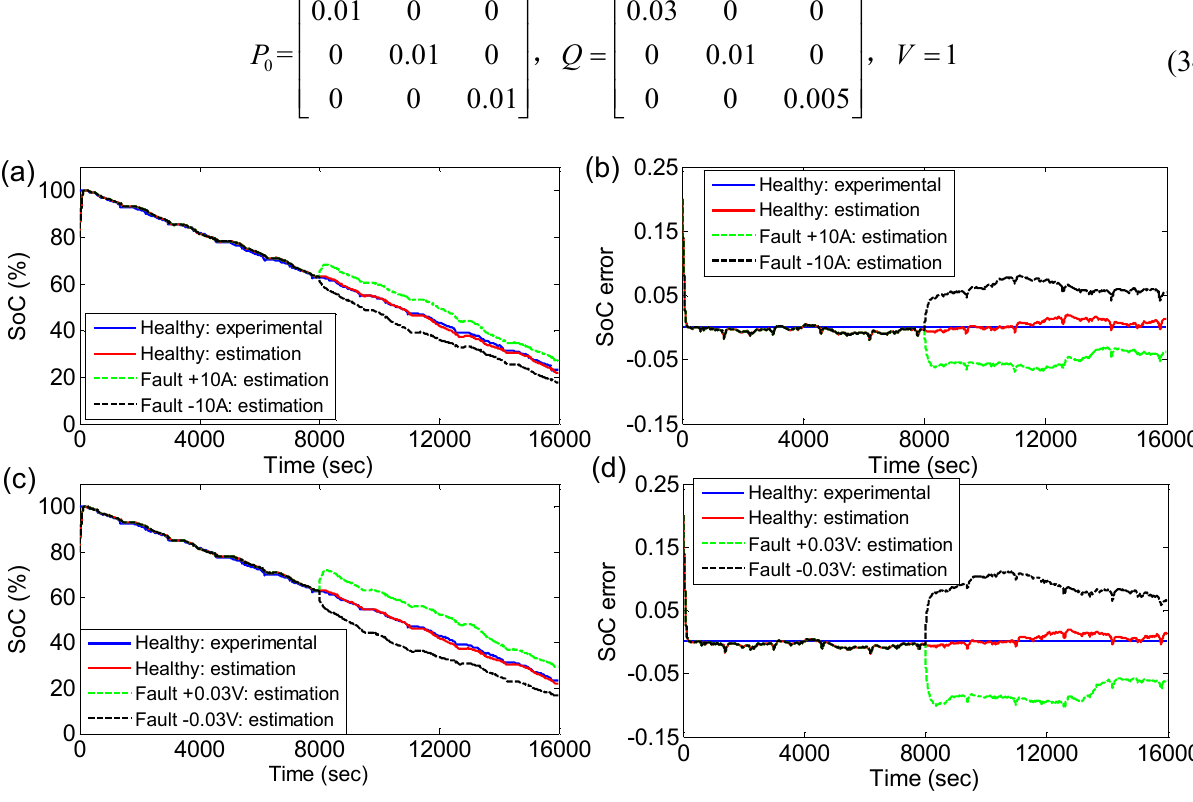
Figure 9. Effects of sensor faults on battery SoC estimation under UDC test. ( a ) SoC estimation results in the current sensor healthy and faulty conditions; ( b ) SoC estimation errors in the current sensor healthy and faulty conditions; ( c ) SoC estimation results in the voltage sensor healthy and faulty conditions; ( d ) SoC estimation errors in the voltage sensor healthy and faulty